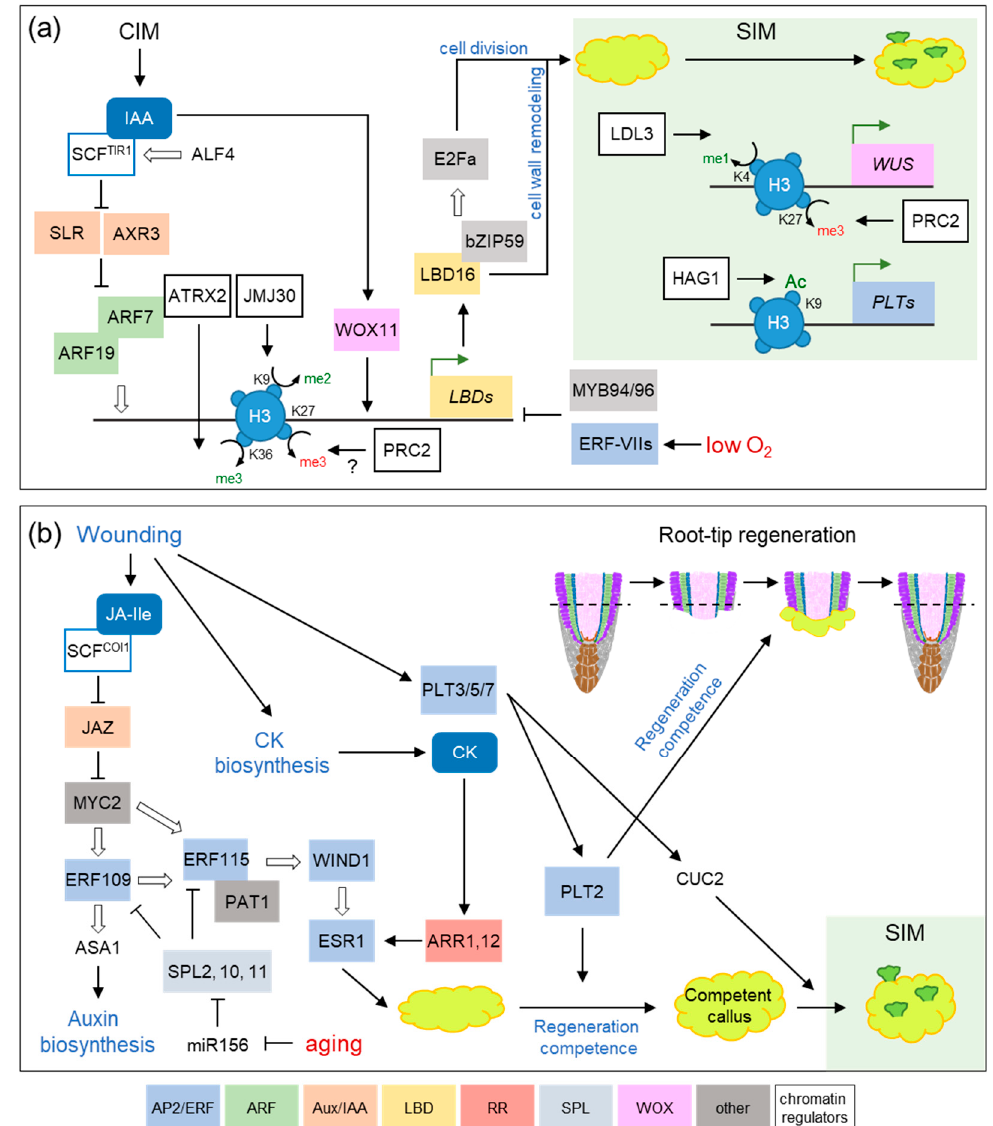
Figure 1. Transcriptional networks involved in cell reprogramming during regeneration. ( a ) Hormone-induced shoot organogenesis. ( b ) De novo root formation after root-tip excision. Positive (wounding, callus-inducing medium (CIM), auxin, etc.) and negative (low O 2 , aging, etc.) signals are shown in blue and red, respectively. Transcriptional and epigenetic regulators (Table 1) are depicted inside boxes of different colors. Each color represents a given DNA binding domain (see main text for legends). White arrows indicate direct upregulation via promoter binding.